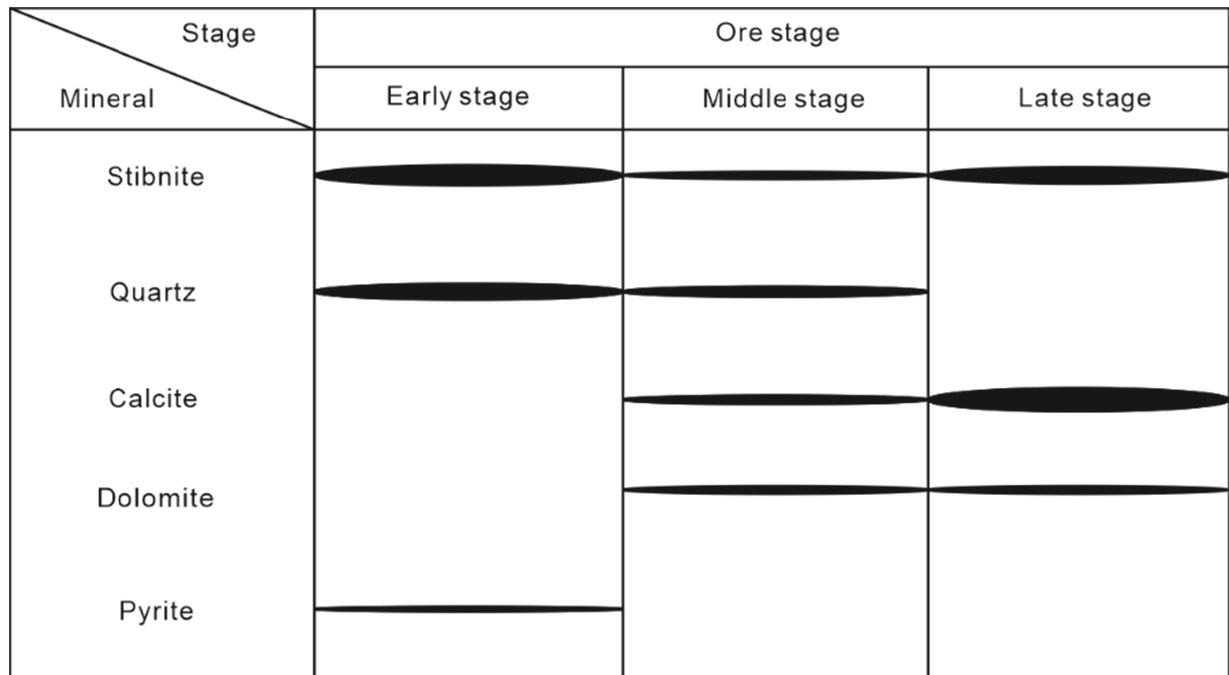
Figure 7. Paragenetic sequence at the Daocaowan Sb deposit.